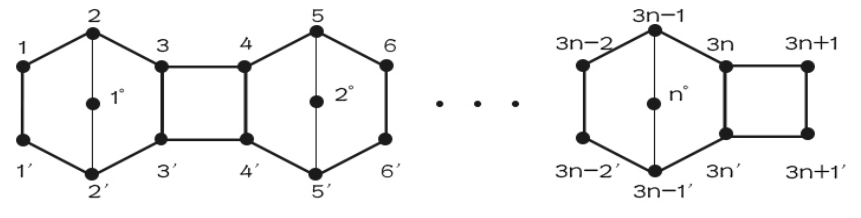
Figure 1. The linear pentagonal derivation chain QP n